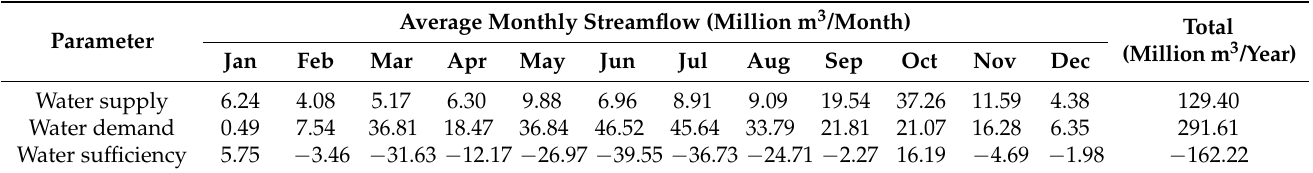
Table 6. Water sufficiency for agriculture in the Lam Takong River Basin under the baseline